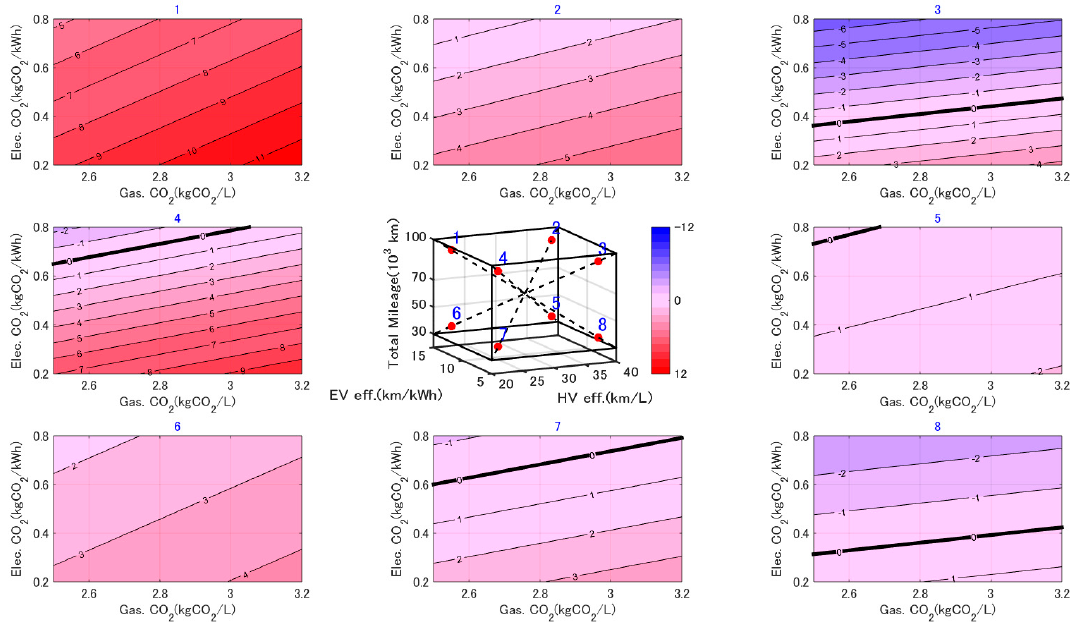
Figure 5. Five-dimensional diagram of comprehensive LCCO 2 comparison between HV and EV with difference of vehicle CO 2 emissions during production ∆ D set to 500 kg.